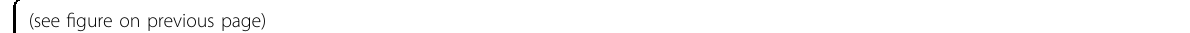
Fig. 3 Heterogeneity of ASCs in adipose tissues revealed by single-cell analysis. a The expression of marker genes that are normally used for de fi ning freshly isolated or cultured ASCs. b Distinct expression pro fi les of the four subpopulations of ASCs. c Enriched Gene Ontology terms of the molecular signature for each subpopulation. Adjusted P value < 0.05, the hypergeometric test. d Subpopulation-speci fi c regulons of each subpopulation obtained by SCENIC analysis. e Immuno fl uorescence staining con fi rmed the presence of the c3-ASC subpopulation in the subcutaneous adipose tissues of lymphedema patients. Staining was performed in tissue sections of three patients. f Immuno fl uorescence staining con fi rmed the presence of the c3-ASC subpopulation in the subcutaneous adipose tissues of healthy donors. Staining was performed in tissue sections of two healthy donors. In e , f , one representative staining image of one subject is shown. Arrows indicate the PDGFRA + PRG4 high cells. Scale bar: 20 μ m. g Flow cytometry analyses of the expression of CD55 (a marker for c3-ASC) in ASCs under lymphedema and healthy conditions. A validation cohort (Validation cohort I; n = 4 for the lymphedema group and n = 7 for the healthy group) independent of the samples subjected to scRNA-seq were used in this analysis. The left two panels show representative contour plots for each group. The bar plot indicates a signi fi cantly higher proportion of CD55 high cells in ASCs (PDGFR α + ) from lymphedema patients than that from healthy donors. Data are presented as means ± SE. * P value < 0.05. Wilcoxon rank-sum test. FSC-A forward